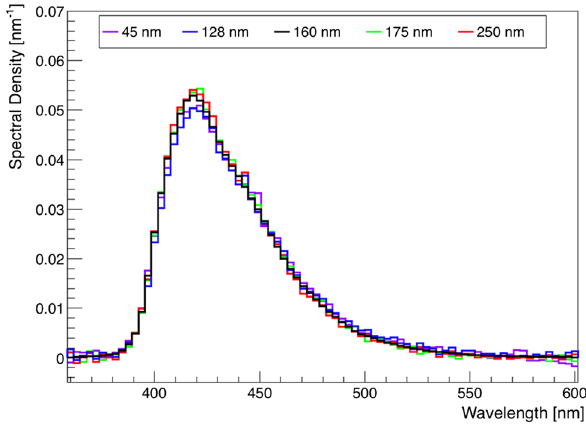
Fig. 15 The best fit to the TPB reemission spectrum for 160 nm inci- dent light. The reemission spectrum fits well to the weighted sum of a Gaussian (red) and an exponentially modified Gaussian (black). The total fit is given in blue Table 3 A table of parameters returned by the best fit to the TPB ree- mission spectrum is Fig. 15 Parameter